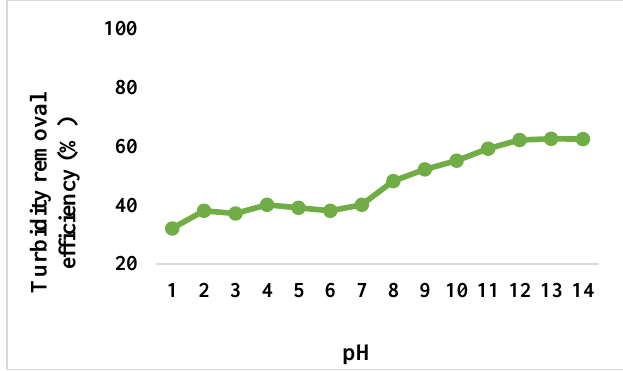
Fig. 6. Effect of pH on turbidity